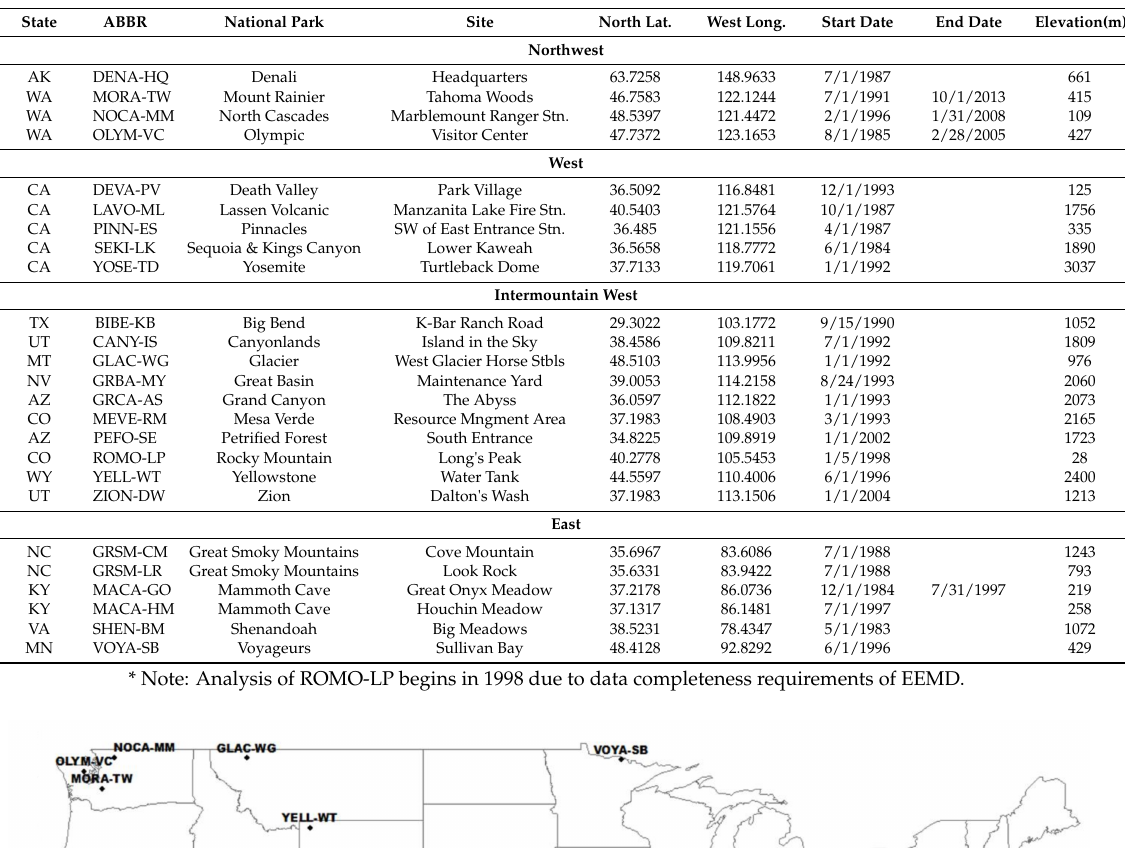
Table 1. Names and locations of the 25 National Park Service Gaseous Pollutant Monitoring Program rural ozone.